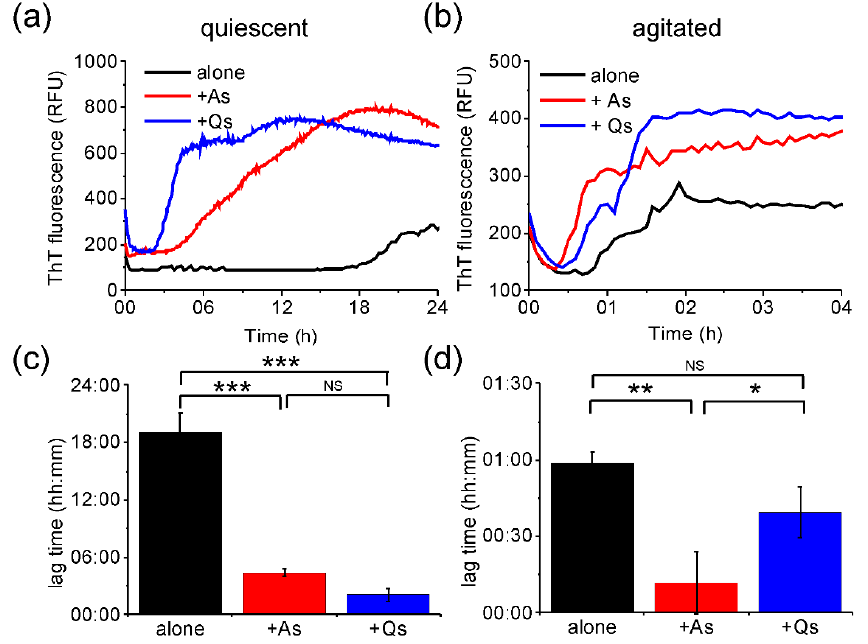
Figure 6. Fibrillation of medin in the presence of pre-formed medin seeds. ThT fluorescence for 20 µ M medin incubated in 20 mM NaPhos, 20 mM NaCl, pH 7.4 at 37 ◦ C under ( a ) quiescent ( b ) and agitated conditions. Medin alone (black), and in the presence of 5% v / v preformed fibril seeds formed with agitation (As, red), or quiescent (Qs, blue). Results are shown as the mean of three replicates. Lag time calculated by fitting the ThT curves as described previously [23,27] for ( c ) quiescent and ( d ) agitated data. Data are shown as the mean ± SD for triplicate curves. NS non-significant; * p < 0.05; ** p < 0.005; *** p < 0.00005. p values were obtained using ANOVA with Bonferroni means comparison.